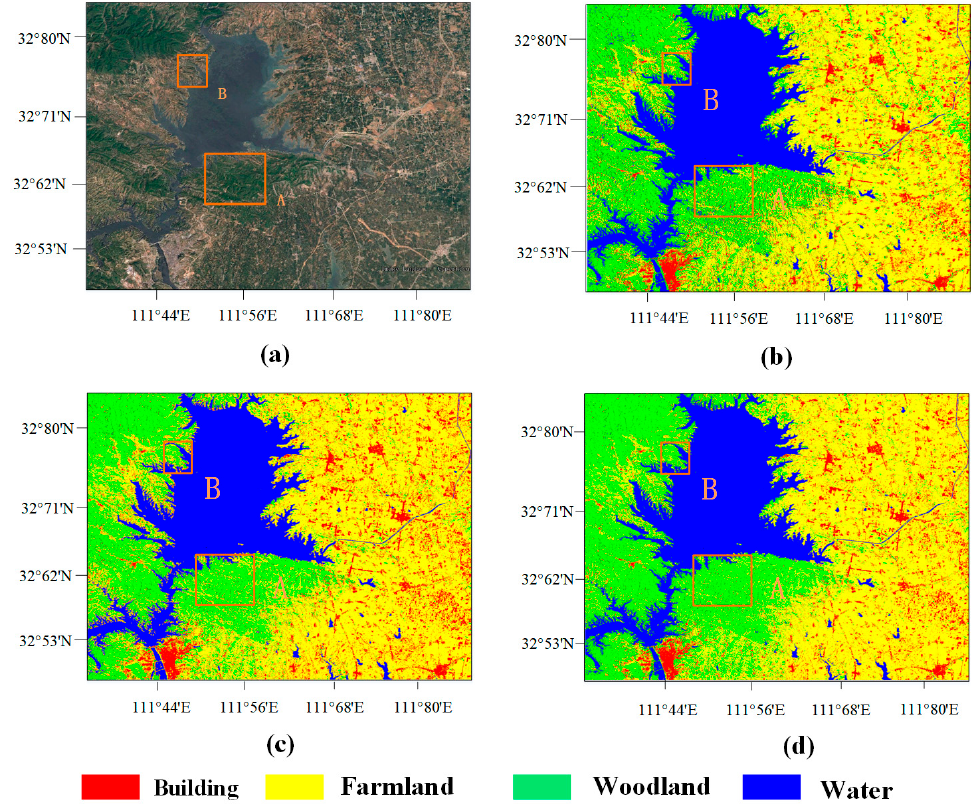
Figure 15. Classification results: ( a ) optical image; ( b ) classification result of Uncompen- Figure 15. Classi fi cation results: ( a ) optical image; ( b ) classi fi cation result of Uncompen- sated_DOPC_DpRVI; ( c ) classification result of Compensated_DOPC; ( d ) classification result